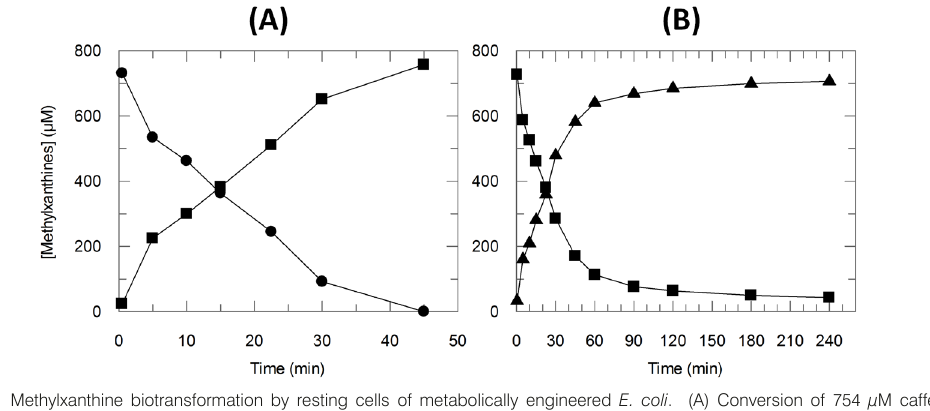
Figure 3. Methylxanthine biotransformation by resting cells of metabolically engineered E. coli . (A) Conversion of 754 μM caffeine ( ) to theobromine ( ) by E. coli RMS001. (B) Conversion of 706 μM theobromine ( ) to 7-methylxanthine ( ) over 240 min by E. coli RMS002.